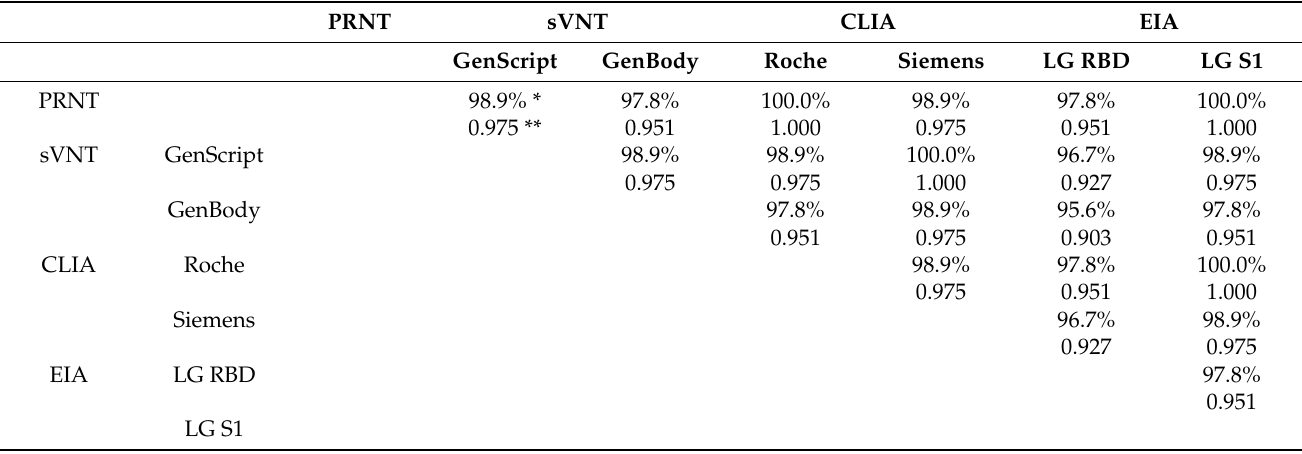
Table A4. Agreement between 7 SARS-CoV-2 antibody tests using 90 samples from vacci- nated